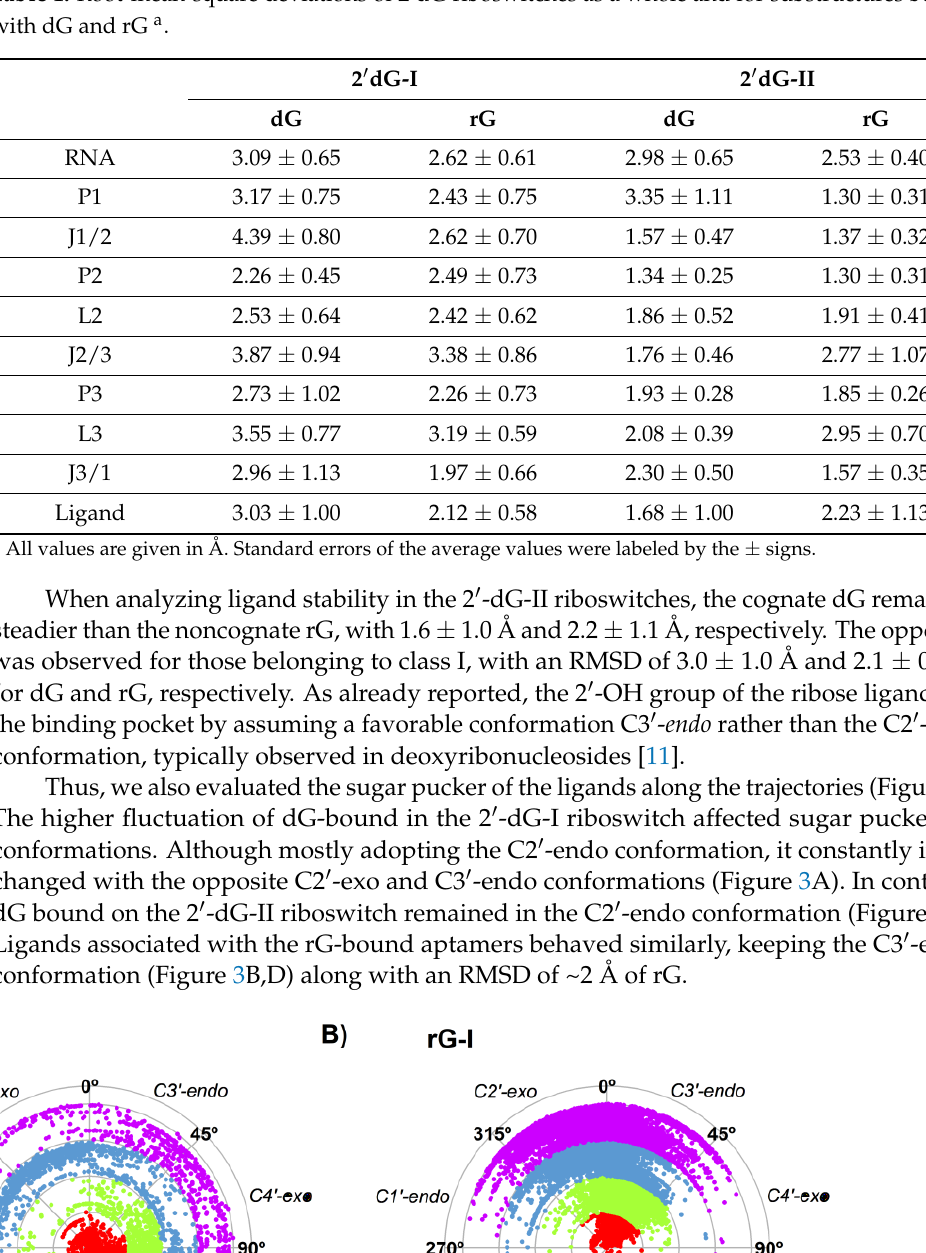
Figure 3. Sugar pucker of dG ( A , C ) and rG ( B , D ) ligands of 2′-dG-I ( A , B ) and 2′-dG-II ( C , D ) riboswitches systems. Each color in the plot represents a different replicate. 2.3. Analysis of Binding Free Energy Binding free energy calculation is essential to clarify ligand association and recognition phenomena. In addition, it is usually applied to quantify the interaction intensity between receptor and ligand, thus ranking ligands based on individual affinities [17]. To understand how structural modifications in the 2′-dG riboswitches might alter the selectivity for the dG and rG, we have calculated the absolute binding free energy (ΔG bind ) using the MM/GBSA method [18]. Several assessments upon different aspects of the 2′-dG riboswitches were elucidated through our simulations. Overall, evaluations of all systems resulted in negative ΔG bind values, indicating spontaneity in the recognition process (Table 2). Of both 2′-dG riboswitches, the class II predicted binding affinity reproduced the experimental data satisfactorily. The prediction for the rG binding was almost the same as the reported experimental value, approximately −11 kcal/mol [12], while calculations for dG were not